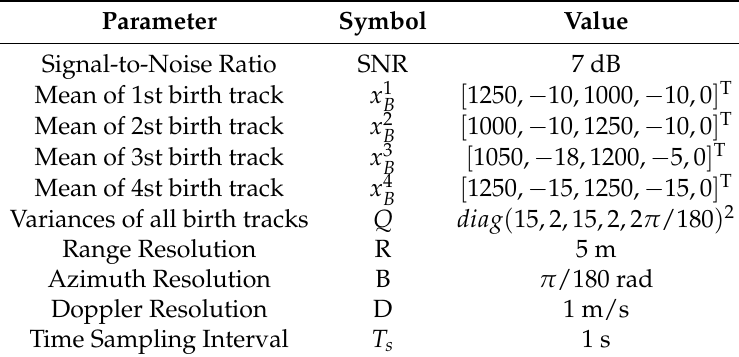
Table 2. Some Simulation